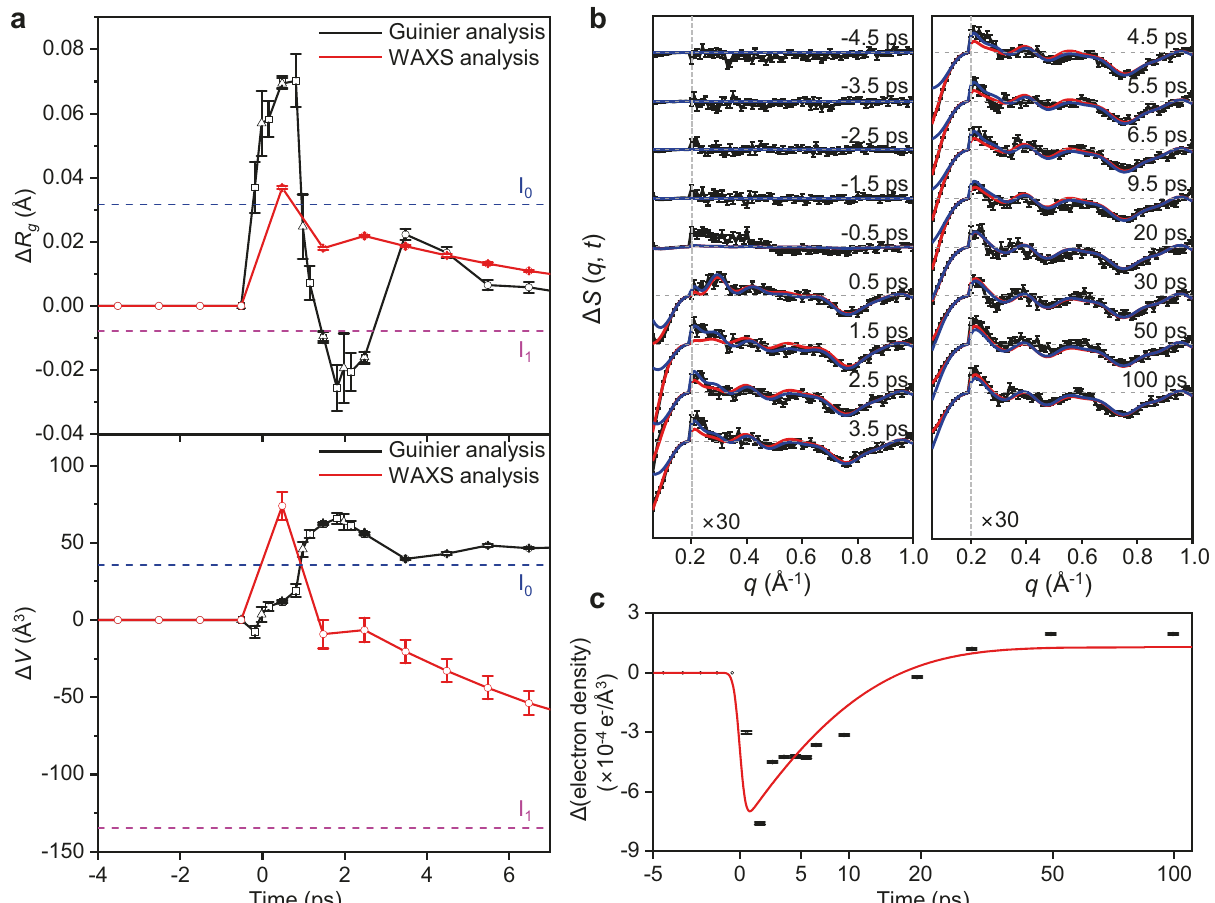
Fig. 4 Analysis of TRXSS data of HbI in the SAXS region using the Guinier analysis and the temporal change of the electron density in the hydration shell. a Time pro fi les of the radius of gyration change ( Δ R g ) and volume change ( Δ V ) with respect to the carboxy structure in the early time domain (<7 ps) after photoexcitation obtained from the Guinier analysis on the SAXS region (black) and WAXS analysis (red). For the Guinier analysis results, the results from the 333-fs-binned data, 500-fs-binned data, and 1-ps-binned data are plotted with square, triangle, and circle, respectively. The R g s and volumes of I 0 and I 1 are marked with blue and magenta dashed lines, respectively. For the Guinier analysis results, the error bars represent the fi tting errors. For the WAXS analysis results, error bars represent SEM. b The experimental femtosecond TRXSS data and its SEM (black), the calculated difference scattering curves after fi tting the electron density of the hydration shell (red), and the calculated difference scattering curves before the fi tting (blue) from − 4.5 to 100 ps. For clarity, the high q region with q ≥ 0.2 Å − 1 is scaled up by 30. c The change of electron density of the hydration shell as a function of time (black) and an exponential decay function with a time constant of 8.7 ps